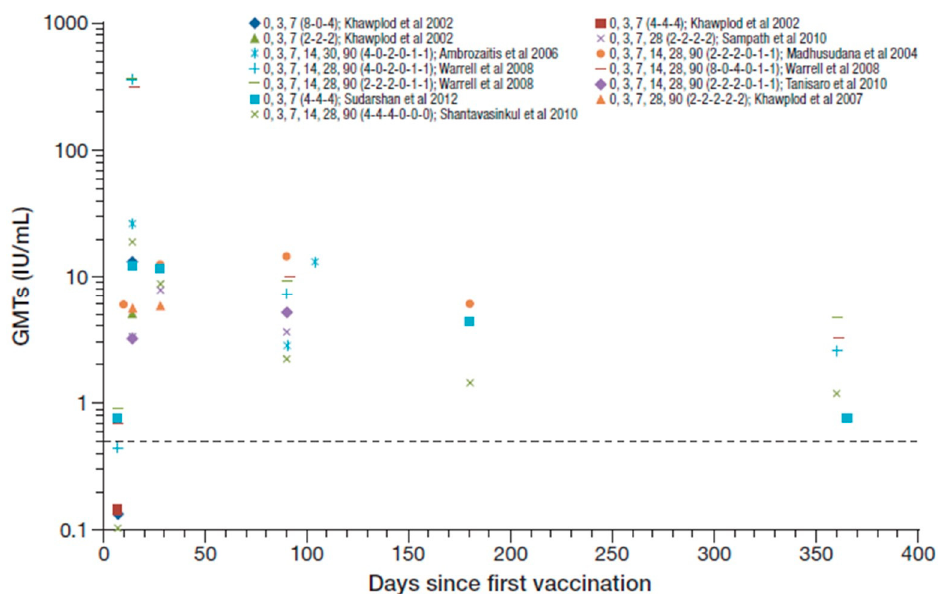
Figure 3. Summary of PEP immunogenicity data from studies with PVRV ID in otherwise healthy participants [regimen summarized as day of vaccination (number of sites per vaccination day) in legend key]. Dotted line marks the 0.5 IU / mL RVNA titer.